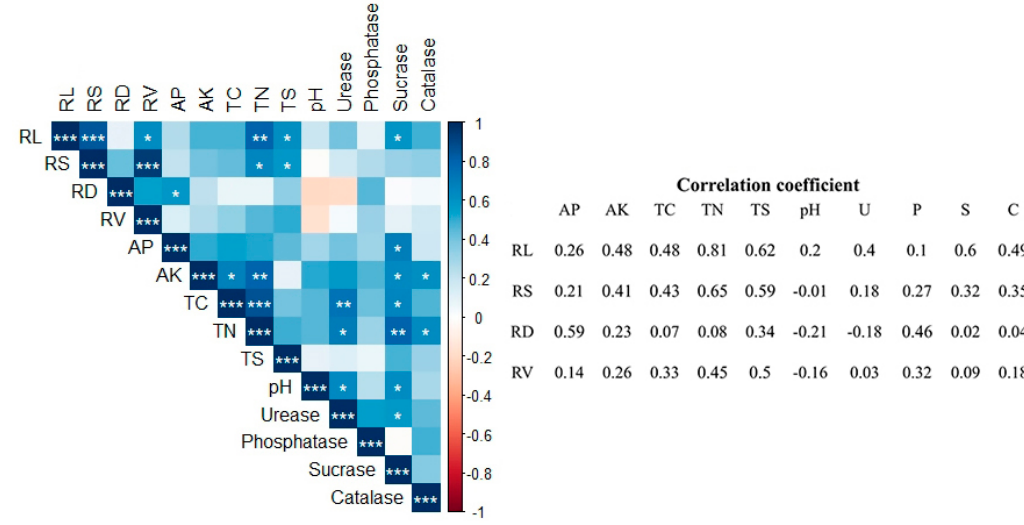
Figure 5. Correlation analysis between root growth parameters, soil nutrients, and soil enzyme activities. Notes: *** indicates significant correlation at p < 0.001; ** indicates significant correlation at p < 0.01; * indicates significant correlation at p < 0.05.